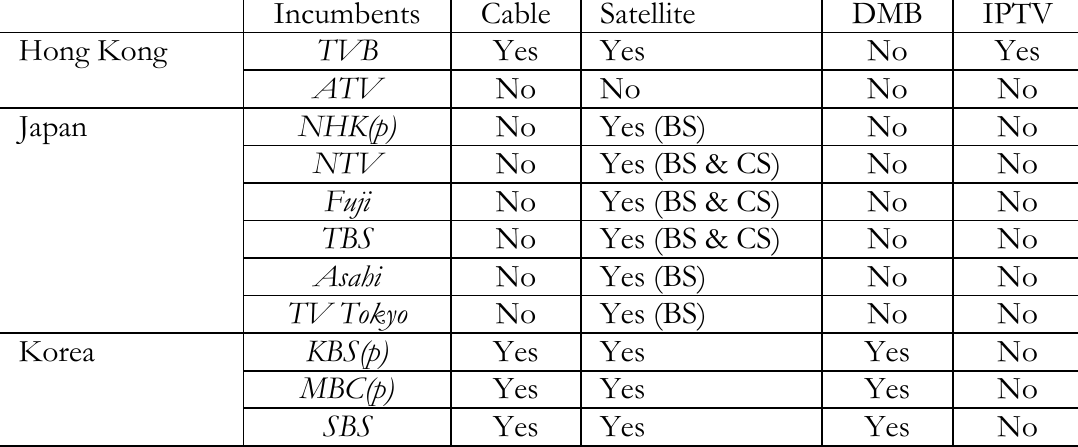
Table 2: Terrestrial Broadcasters’ Participation in New Broadcast Media Incumbents